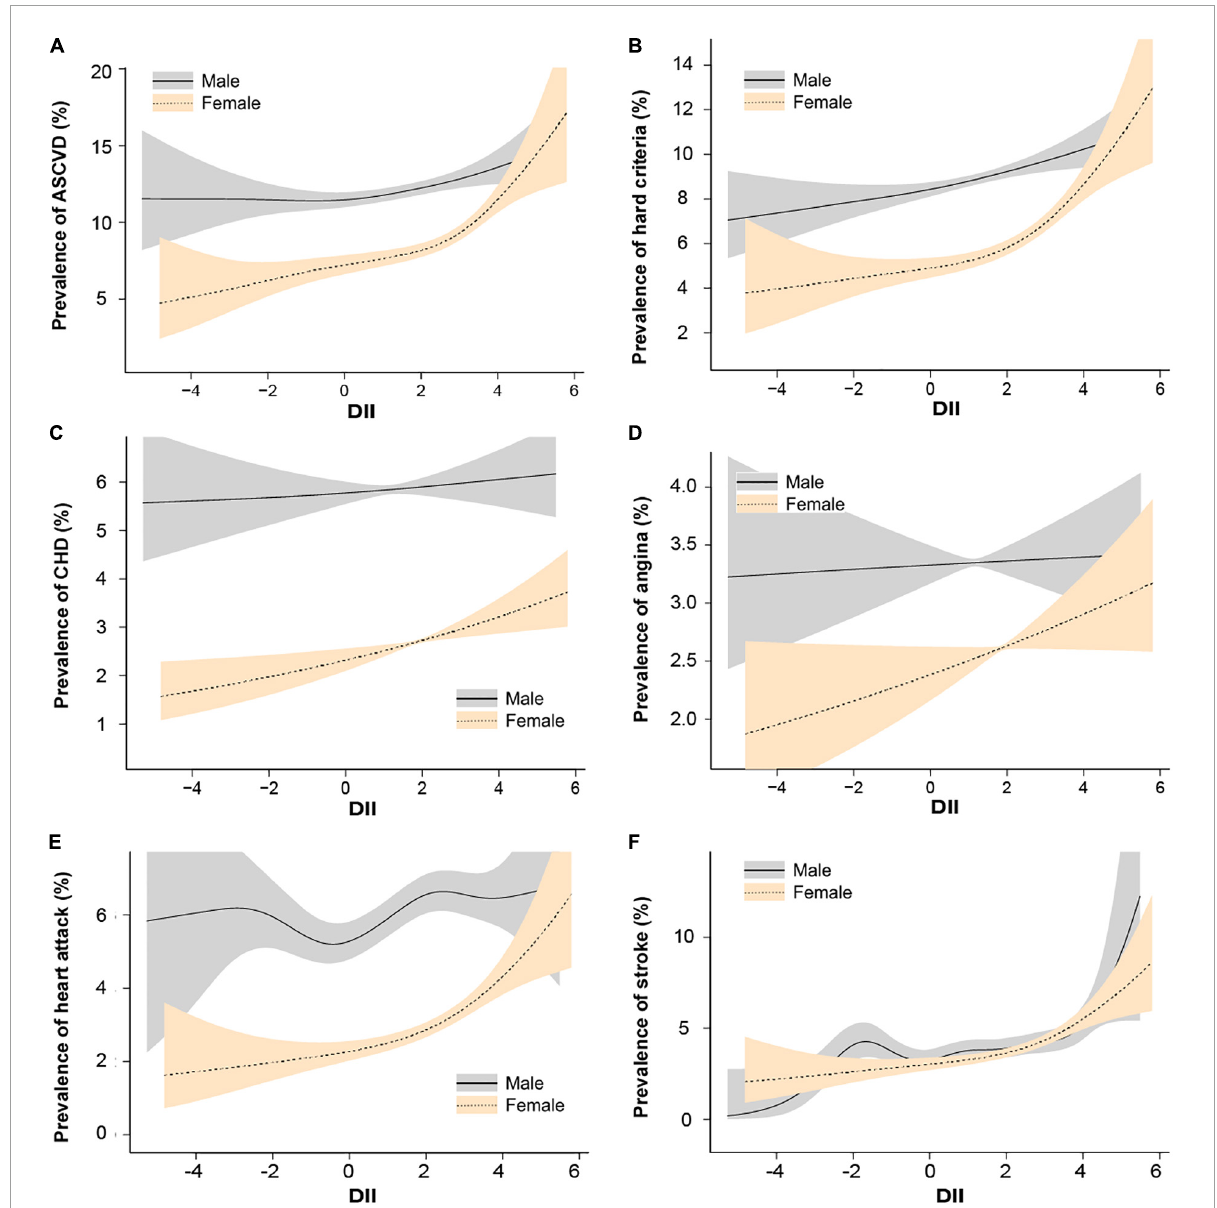
FIGURE3 Spline smoothing of dietary inflammatory index (DII) and atherosclerotic cardiovascular diseases stratified by sex, weighted. We adjusted age, sex, race or ethnicity, body mass index, education level, smoking status, poverty, insurance, hyperlipemia, hypertension, and diabetes. (A) Atherosclerotic cardiovascular disease. (B) Hard criteria (including heart attack and stroke). (C) Coronary heart disease. (D) Angina. (E) Heart attack. (F) Stroke. The solid line represents males and the gray shading represents the 95% confidence interval for males. The need line represents females and the orange shading represents the 95% confidence interval for